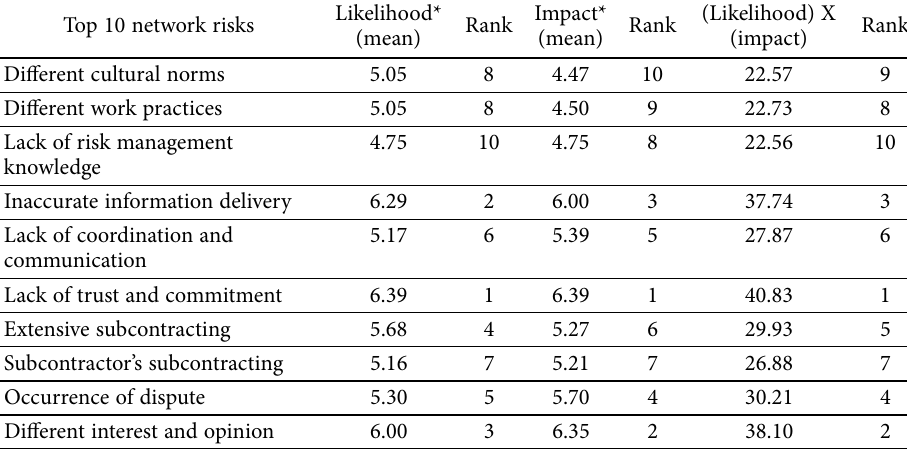
Table 3. Top 10 network risks – likelihood & impact Top 10 network